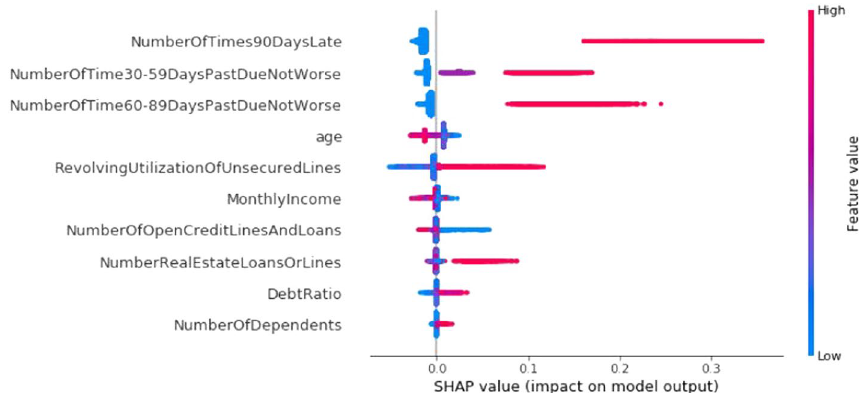
Fig. 6 SHAP interpretation of Random Forest in the empirical example